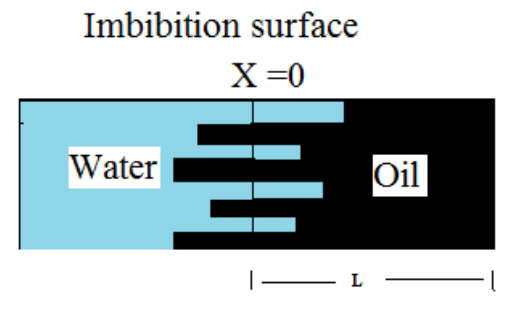
Fig. 1: Inclination effect in counter-current imbibition phenomenon